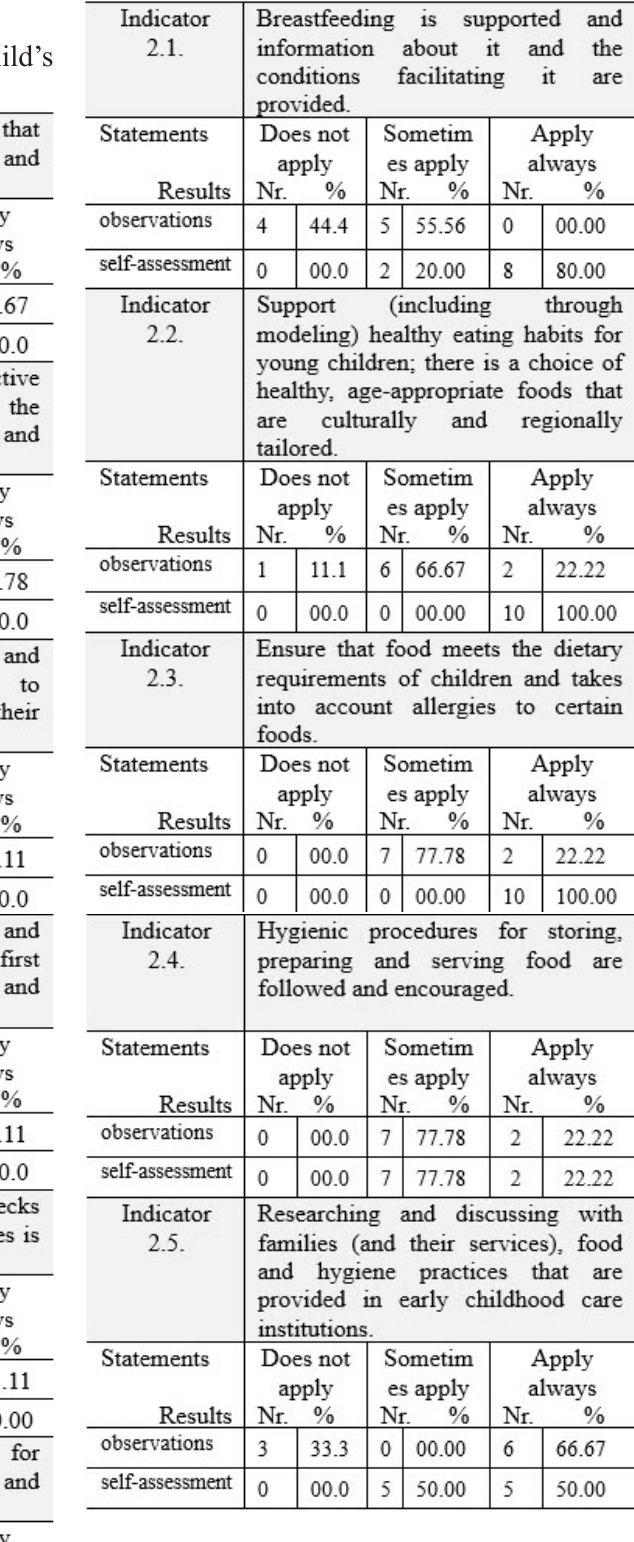
Table 15. Principle 2: Meeting the nutri - tional needs of the